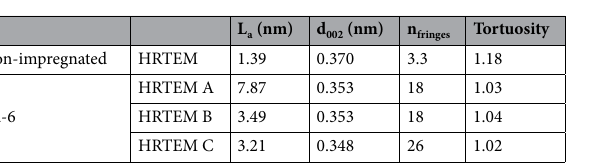
Table 2. Parameters of the graphenic structures from processing of the HRTEM